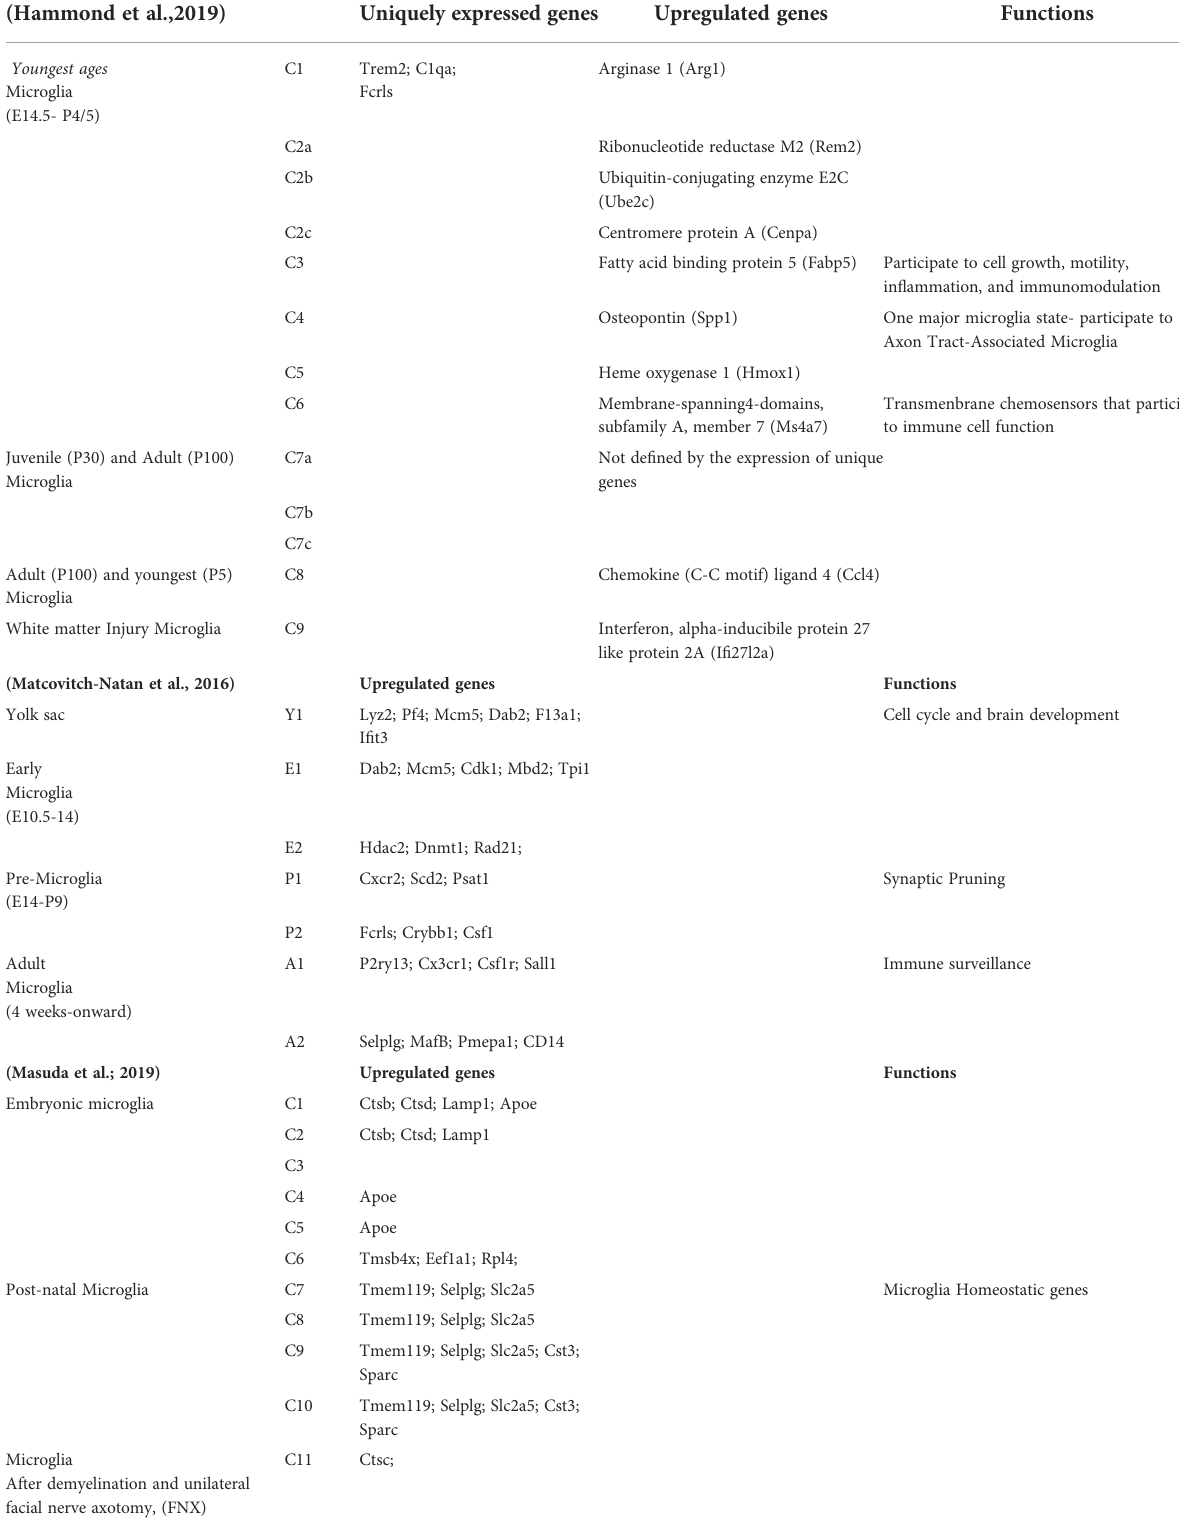
TABLE 1 Microglia identity and spatial heterogeneity: Recapitulation of expressed markers and functions of clustered microglia in different temporal and spatial